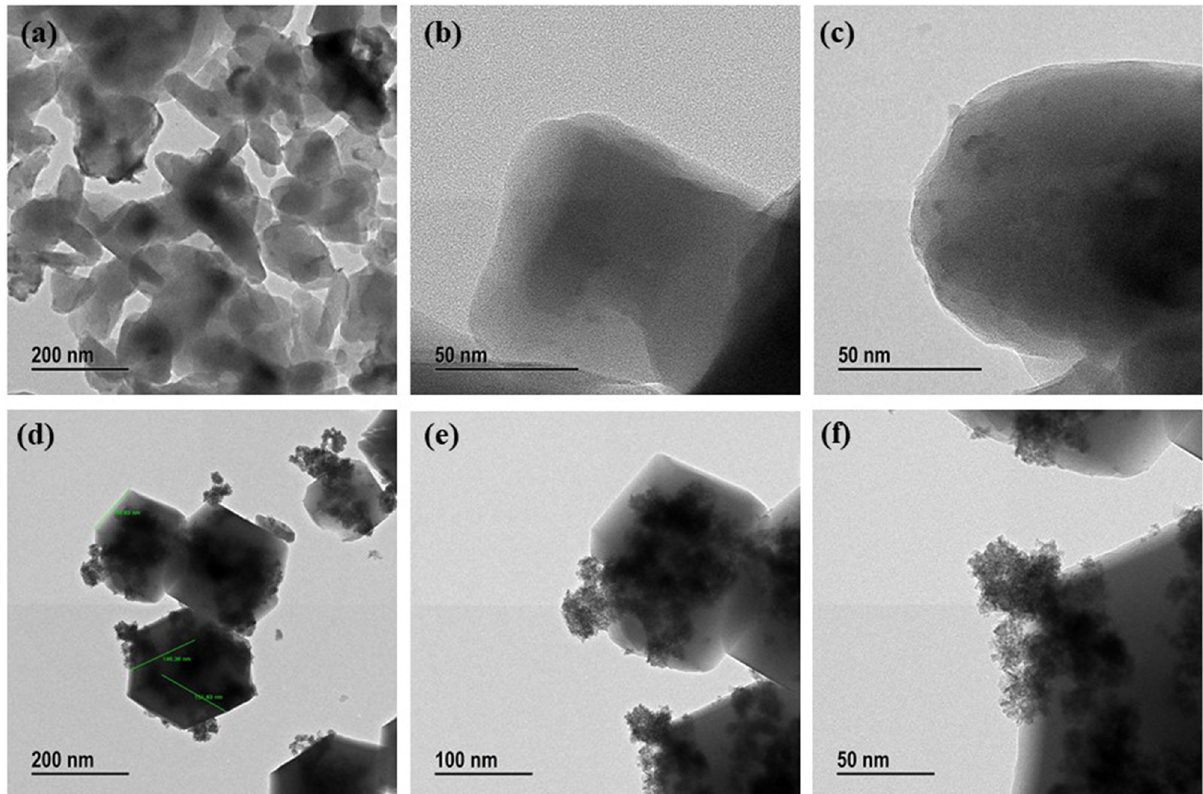
Figure 6: HR - TEM images of ( a – c ) CdS@ZIF - 8 and ( d – f ) CTAB - capped CdS@ZIF -